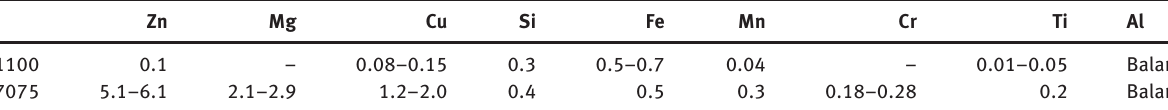
Table 1 Chemical compositions of 1100 and 7075